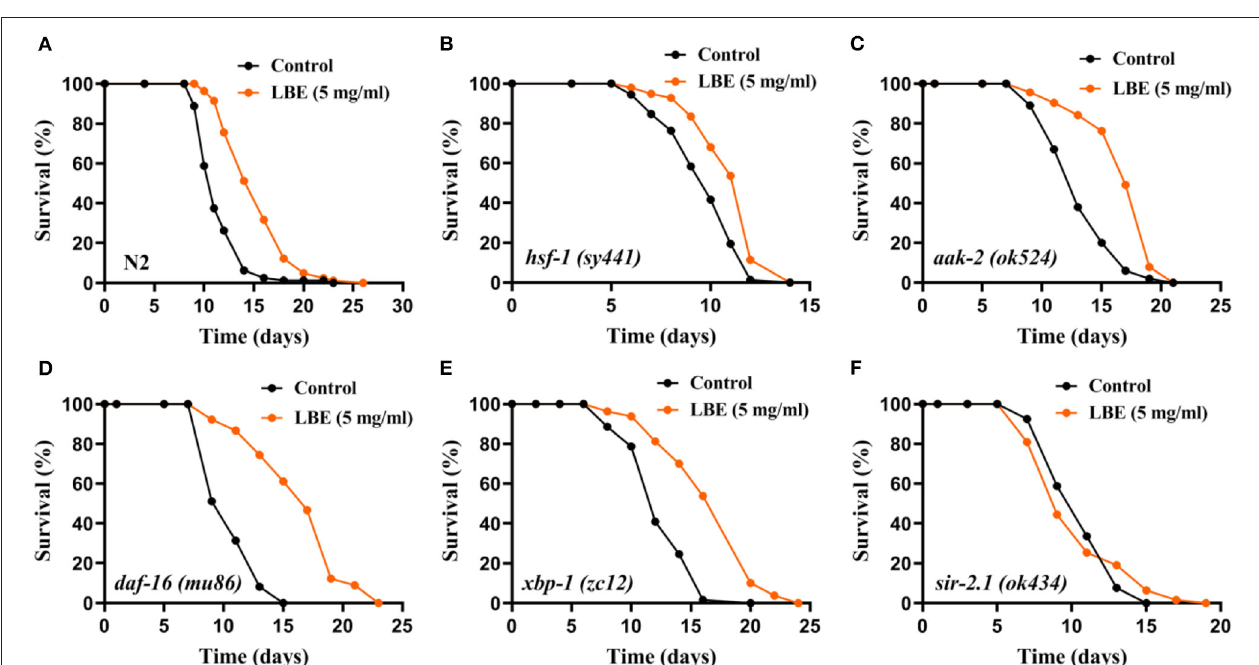
FIGURE 4 | LBE extends lifespan depending on sir-2.1 under unfavorable conditions. (A) Survival curves of N2 worms cultured with vehicle or 5 mg/ml LBE at 20 ◦ C (control: n = 80, mean lifespan 11.6 days; 5 mg/ml LBE: n = 82, mean lifespan 15.5 days; p < 0.0001). (B) Survival curves of hsf-1 (sy4421) worms cultured with vehicle or 5 mg/ml LBE at 20 ◦ C (control: n = 72, mean lifespan 9.7 days; 5 mg/ml LBE: n = 97, mean lifespan 11.1 days; p < 0.0001). (C) Survival curves of aak-2 (ok524) worms cultured with vehicle or 5 mg/ml LBE at 20 ◦ C (control: n = 100, mean lifespan 13.4 days; 5 mg/ml LBE: n = 114, mean lifespan 17.1 days; p < 0.0001). (D) Survival curves of daf-16 (mu86) worms cultured with vehicle or 5 mg/ml LBE at 20 ◦ C (control: n = 86, mean lifespan 10.8 days; 5 mg/ml LBE: n = 90, mean lifespan 16.6 days; p < 0.0001). (E) Survival curves of xbp-1 (zc12) worms cultured with vehicle or 5 mg/ml LBE at 20 ◦ C (control: n = 61, mean lifespan 12.7 days; 5 mg/ml LBE: n = 80, mean lifespan 17.3 days; p < 0.0001). (F) Survival curves of sir-2.1 (ok434) worms cultured with vehicle or 5 mg/ml LBE at 20 ◦ C (control: n = 119, mean lifespan 10.8 days; 5 mg/ml LBE: n = 63, mean lifespan 10.6 days; p = 0.981). All the results are representative of at least two independent